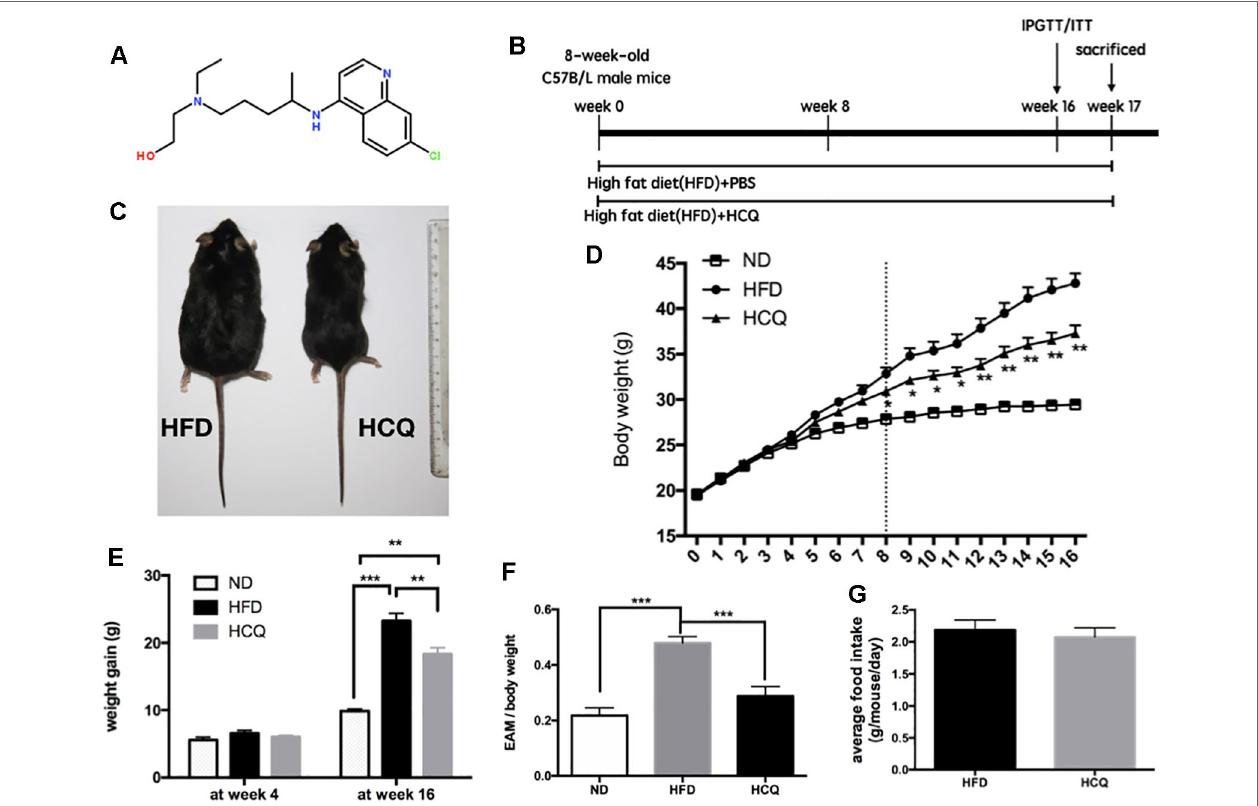
FIGURE 1 | Effects of hydroxychloroquine (HCQ) treatment on body weight and fat mass in HFD-induced obese mice. (A) Chemical structure of HCQ. Its molecular formula is C 18 H 26 ClN 3 O. Molecular weight (MW): 335.872 g/mol. (B) Timeline and scheme of the in vivo experiment. Eight-week-old male C57BL/6 mice were given high-fat diet (HFD) with or without HCQ [1 mM, 40 mg/kg of body weight (BW)/day] by feeding mice ad libitum for 16 weeks. After 16 weeks, all mice were subjected to the glucose tolerance test or test for insulin tolerance ( n = 12) and allowed to recover for 1 week. Then, liver tissue and serum were harvested for biochemical analysis. (C) Representative pictures of mice at end of the experiment, scale bar = 1 cm. (D) Growth curve and (E) body weight gain of mice in the normal diet (ND), HFD, and HFD + HCQ groups after 4 and 16 weeks. Ten samples were taken per group for each assay. (F) The epididymisadipose mass (EAM) of body weight in each group at 16 weeks. (G) The average food intake. Data were presented as mean ± standard error of the mean (SEM) in each group. Significant difference: * P < 0.05, ** P < 0.01 vs. the ND or HFD